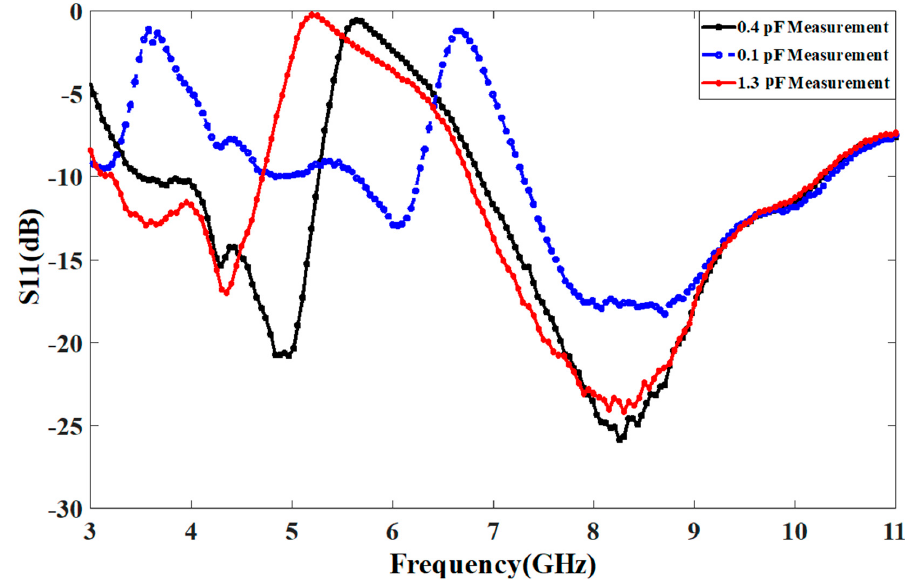
Figure 5. Measured response of the antenna with the proposed resonator integrated (changing Cap1).